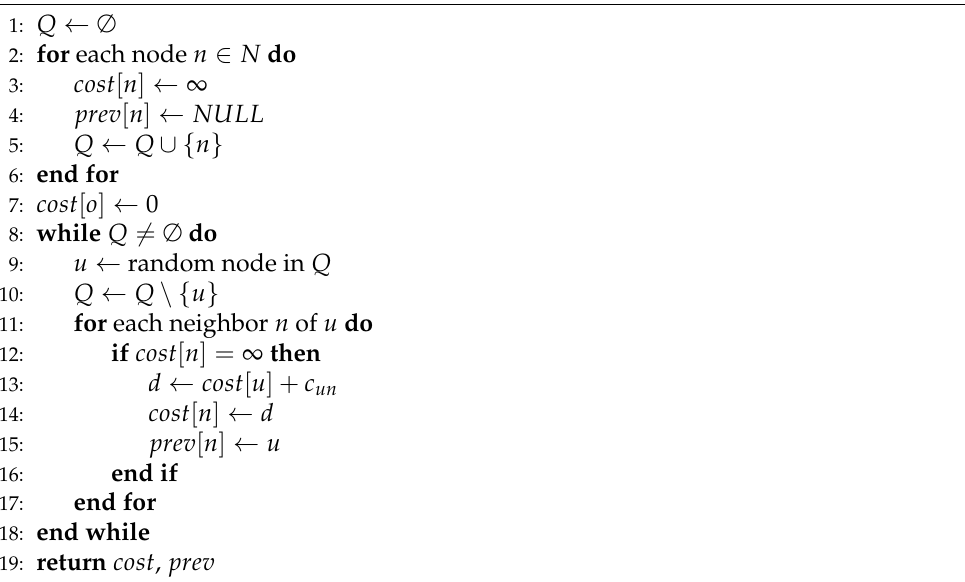
Algorithm 7 RandomTree ( G ( N , A ) , o , d